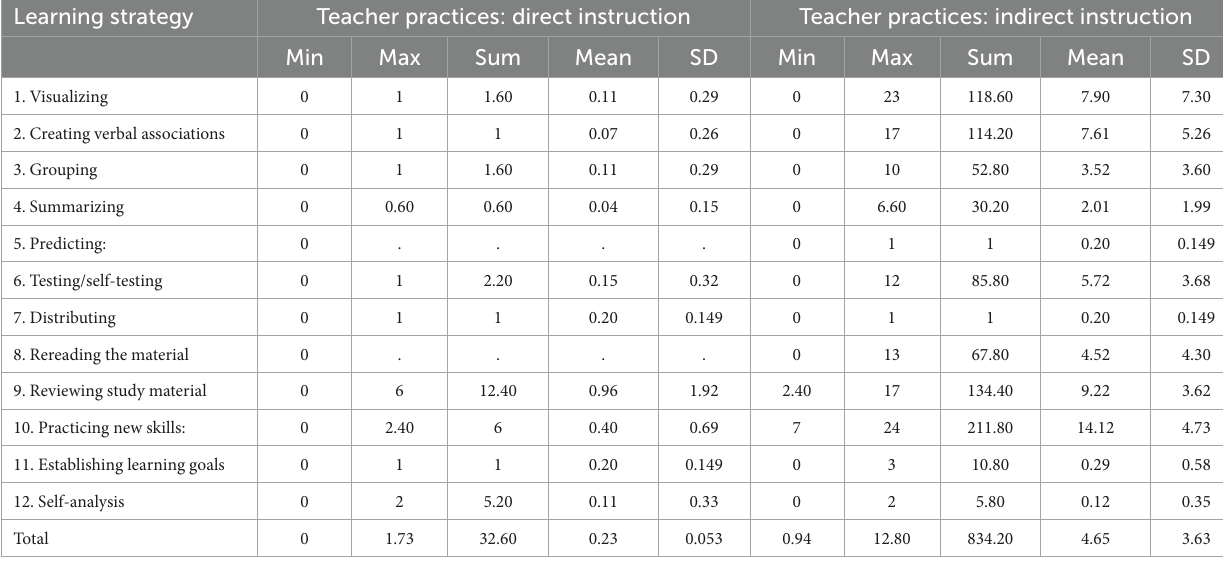
TABLE 2 Descriptive statistics of direct and indirect instruction of learning strategies. Learning